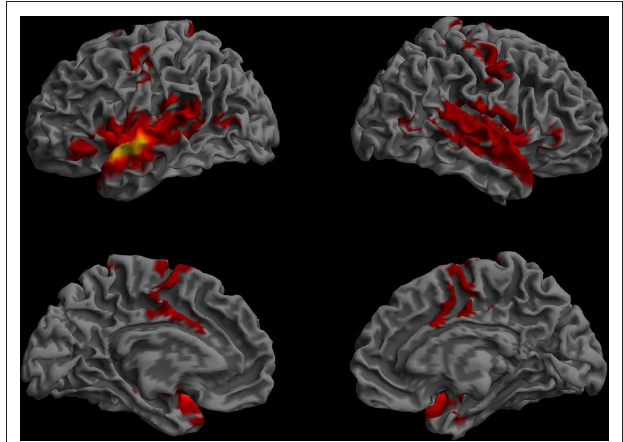
Figure 7 | resting-state functional connectivity of the left anterior STg/ BA22 rOi. (Lateral and medial views of the left and right hemispheres, p < 0.01, corrected, cluster extent > 100 mm 3 , colors indicate t -values, dark red = lowest, yellow-white = highest, with the voxels within the ROI showing the highest correlation).